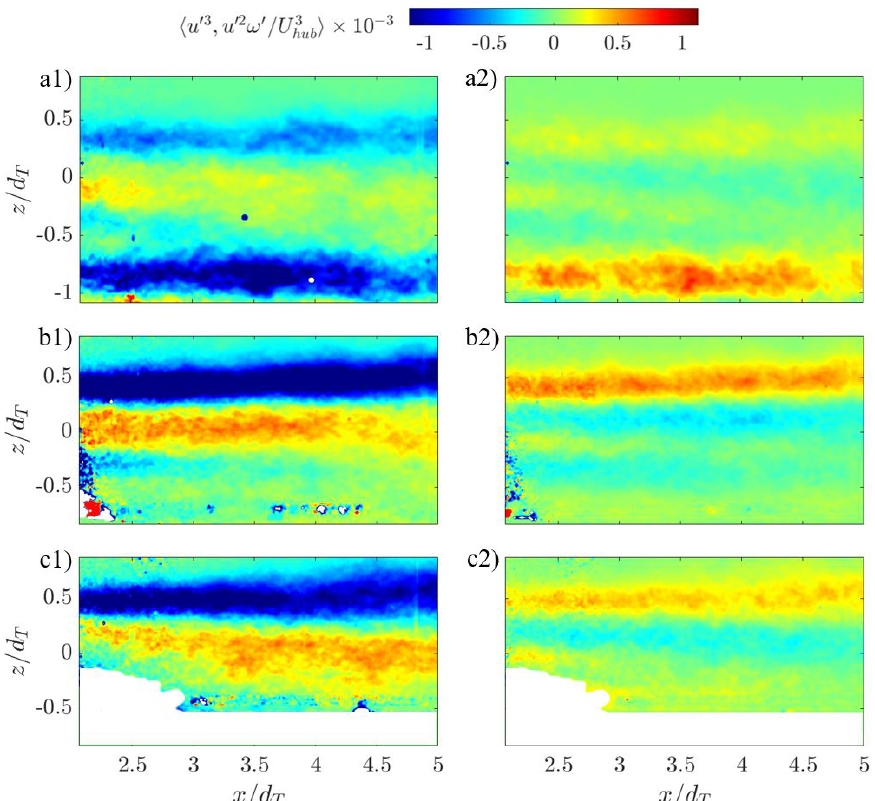
Figure 8. Transport of streamwise contribution of turbulent kinetic energy in the center plane ( y = 0) with distribution of ( a1 , b1 , c1 ) (cid:104) u (cid:48) 3 / U 3 ( b1 , b2 ) 0, and ( c1 , c2 ) 0.42